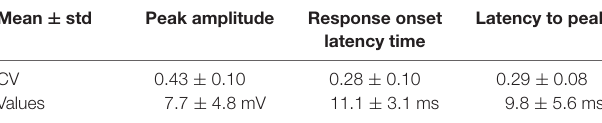
TABLE 2 | Quantification of single-pulse responses in the population of neurons. Mean ±